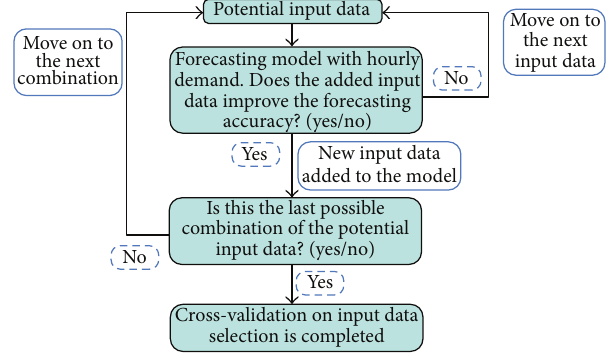
Figure 3: Data selection